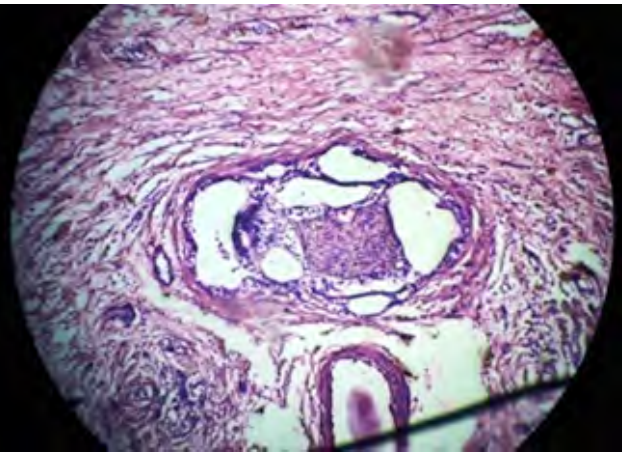
Fig 1 : H and E stained sections of Perineural invasion in adeno- carcinoma (color picture available